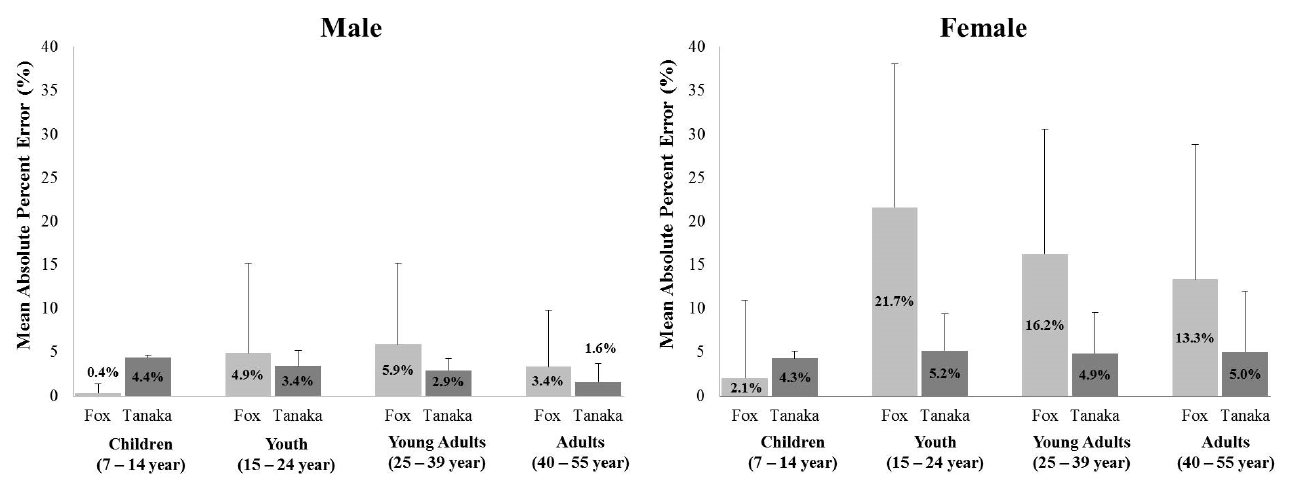
Figure 3. Mean absolute percentage error (MAPE) of maximal heart rate for Fox (cid:48) s equation and Tanaka (cid:48) s equation based on direct measured maximal heart